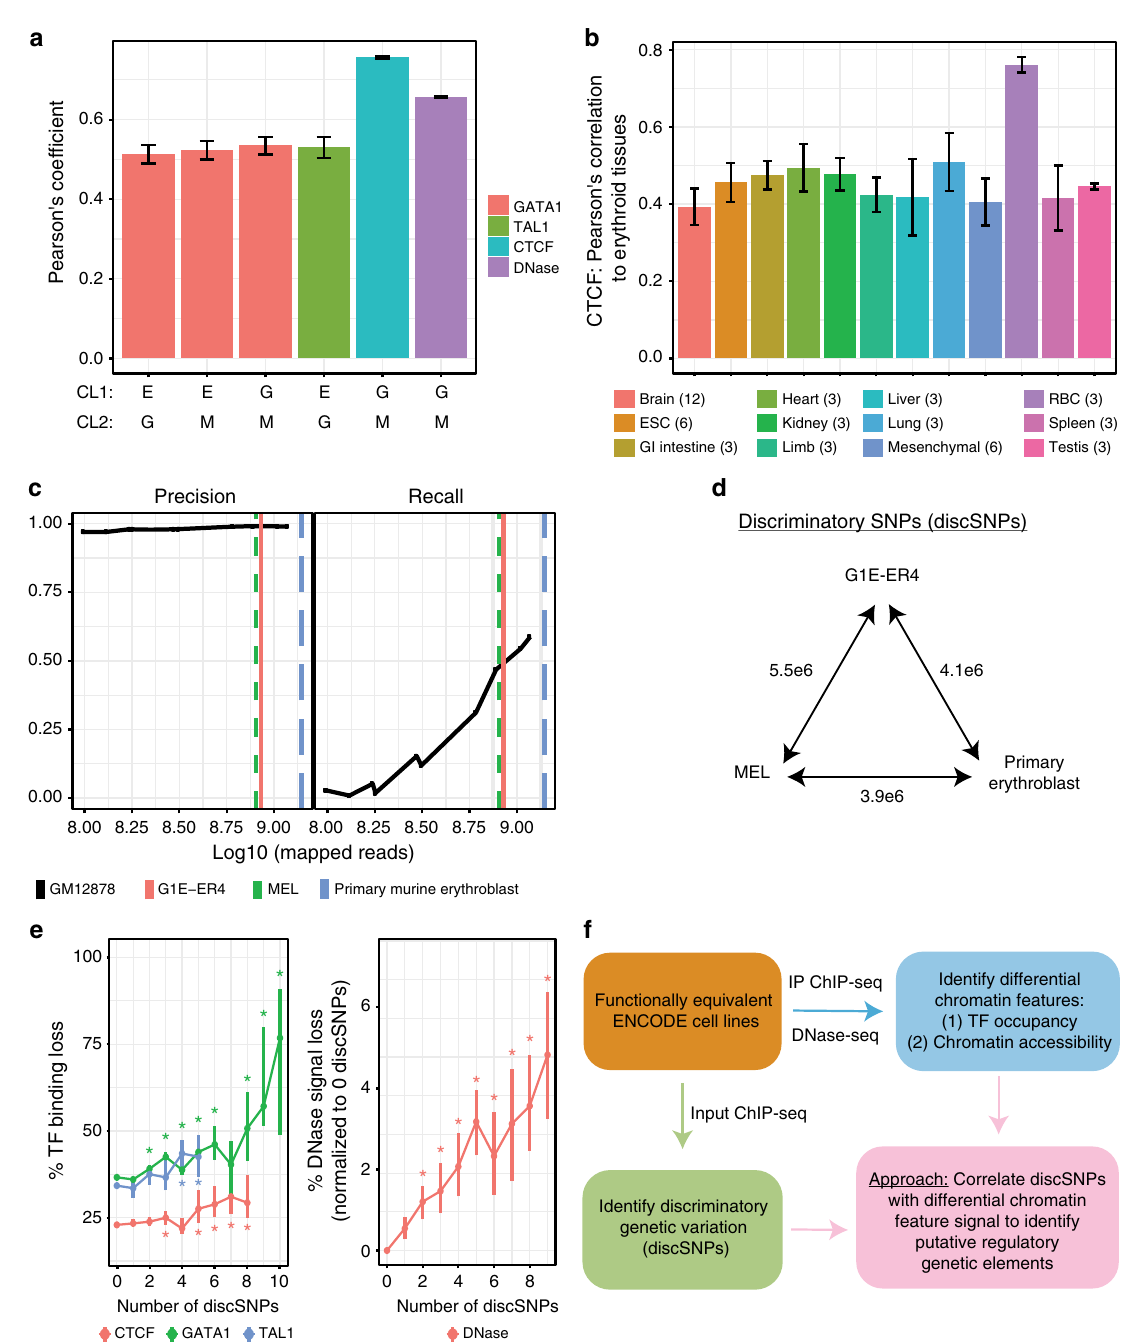
Fig. 1 Control ChIP-seq data reveals extensive genetic variation between functionally equivalent ENCODE cell lines. a Pearson's correlation coef fi cient (PCC) of TF binding and DNase hypersensitivity pro fi les between pairs of erythroid cell lines (E = erythroblast, G = G1E-ER4, M = MEL) at commonly called peaks. PCC ± 95% CI. b PCC of CTCF binding between indicated tissues and erythroid tissues (G1E, G1E-ER4, MEL). Mean ± SEM, number of comparisons listed in fi gure. c Precision and recall of using input ChIP-seq data in GM12878 cells to identify homozygous variants relative to the hg19 reference genome. Vertical lines denote the number of input ChIP-seq reads available for the murine erythroid cell lines. d Number of discriminatory SNP (discSNP) variants between each pair of erythroid cell lines. e Median percent signal loss (relative to stronger binding signal) at TF peaks or DNase hypersensitivity (DHS) peaks between erythroid cell lines, separated by the number of discSNPs located within the TF/DHS peak. TF binding loss % with 0 discSNPs re fl ects the background level of variation in TF peak intensities between cell lines despite identical underlying DNA sequences. DNase percentages are normalized to the 0 discSNP data point within peaks of identical length. *Wilcoxon's p < 0.05 for comparison to peaks lacking discSNPs. Vertical bars represent 95% con fi dence intervals by bootstrapping. f Schematic of the overall analysis approach that uses genetic variants to probe determinants of TF binding